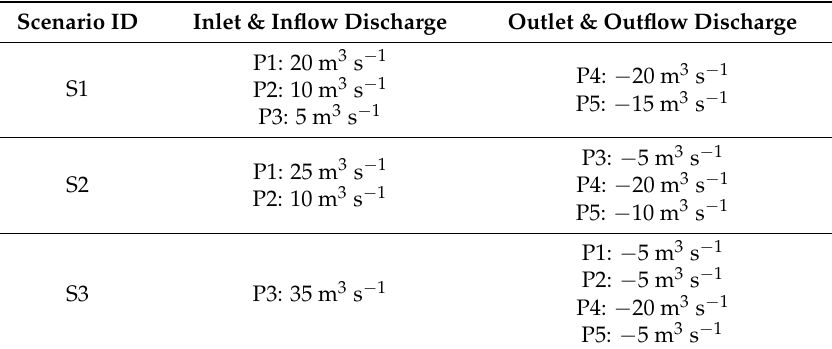
Table 3. Water diversion scenarios.